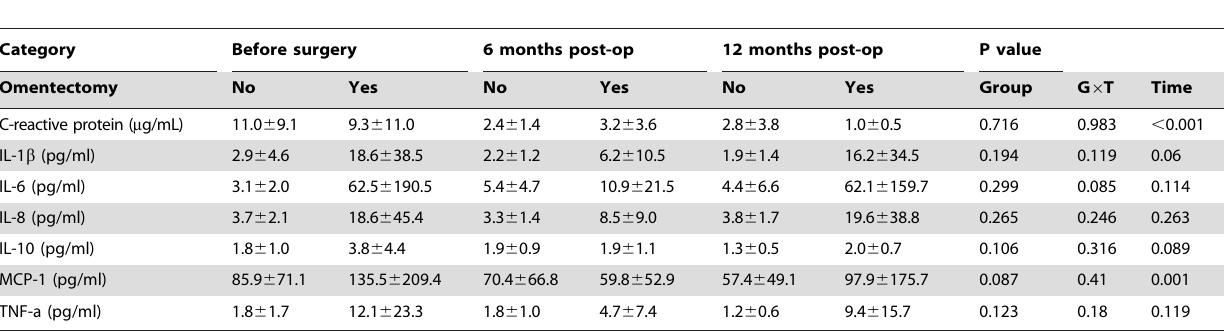
Table 2. Serological measures of inflammation determined before and after RYGB with and without omentectomy.